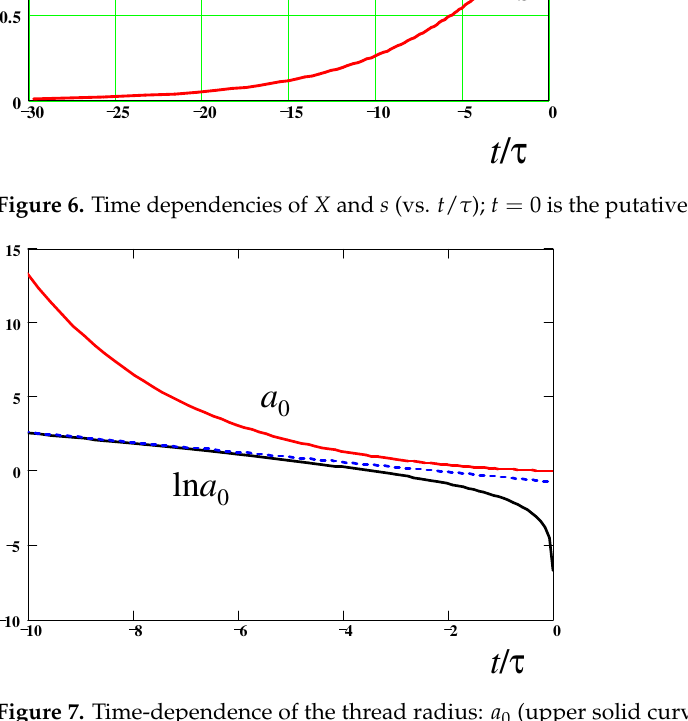
Figure 7. Time-dependence of the thread radius: a 0 (upper solid curve) and ln a 0 (lower curve) vs. t / τ . The dashed line indicates the asymptotic exponential law, Equation